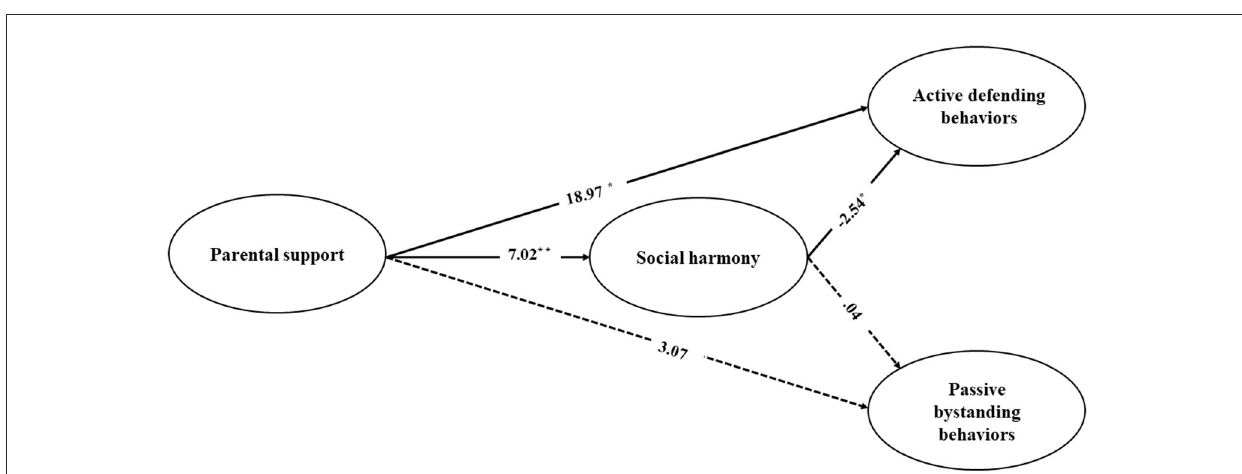
FIGURE2 Mediation model of the association between T1 parental support and T2 behaviors of bullying bystanders (T2, active defending behaviors; T2, passive bystanding behaviors) via T2 social harmony with unstandardized beta weights and significance levels added. To simplify the presentation, the correlations between independent variables, and the correlation lines and predicting pathways involving covariates are not shown in the figure. Solid lines indicate relations that were significant at p < 0.05. Parameter estimates for pathways that were not statistically significant at p < 0.05 and p < 0.01 (two-tailed) are depicted as dashed lines in the figure. * p < 0.05, ** p <